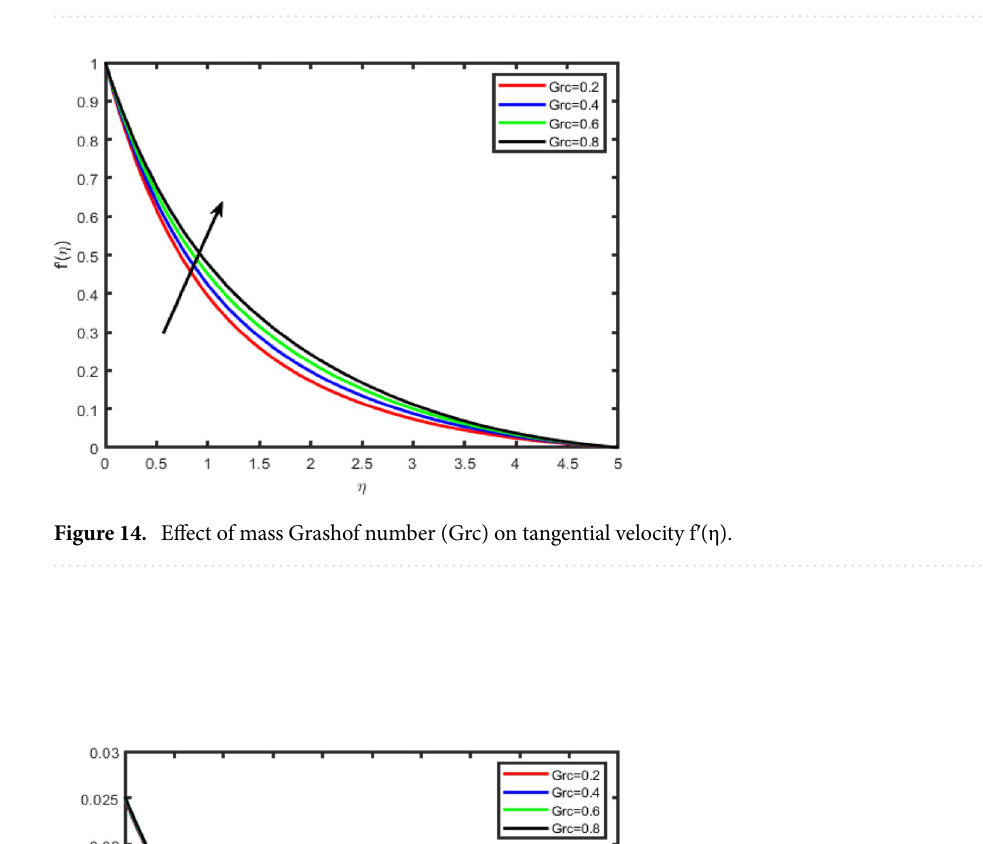
Figure 13. Effect of thermal Grashof number (Grx) on transverse velocity g(η).